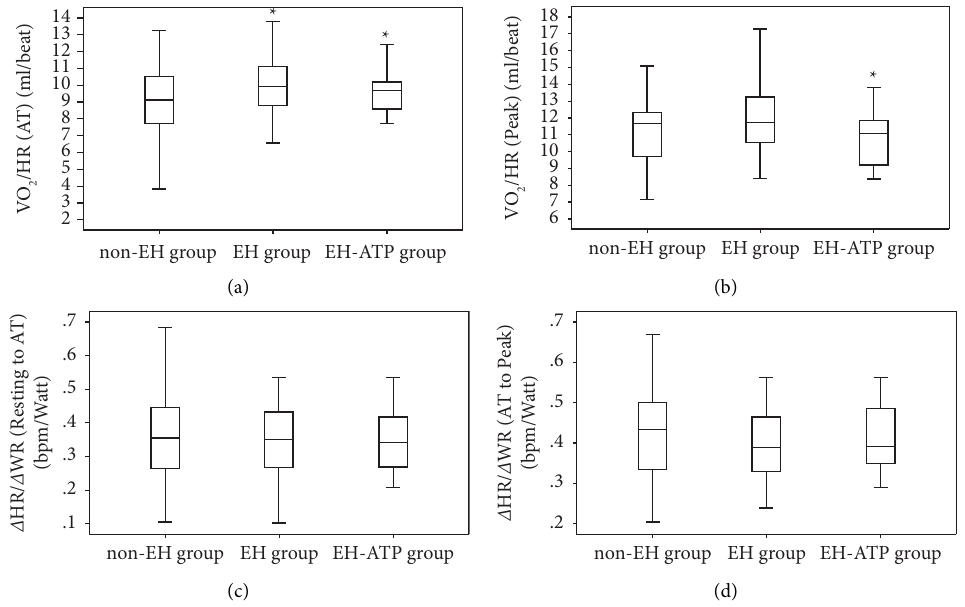
Figure 4: Comparison of cardiac stroke volume and heart rate response during